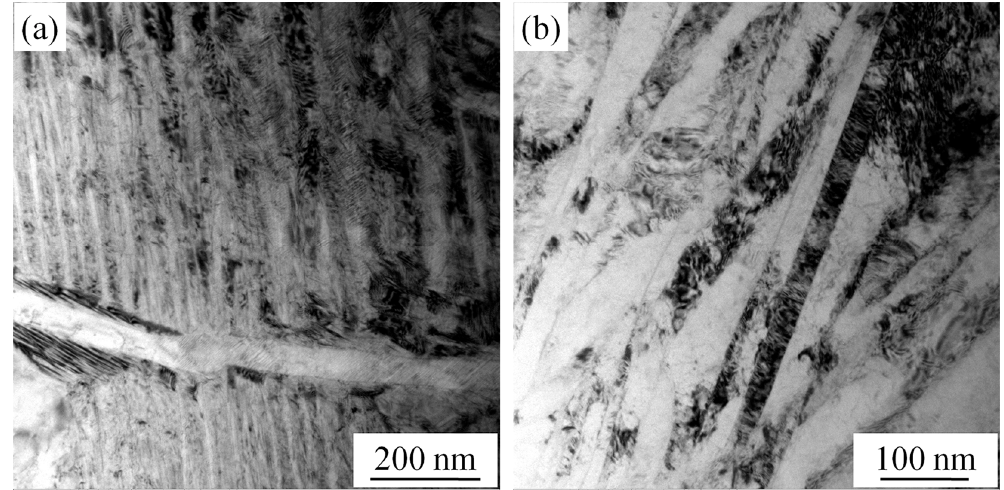
Figure 1. Transmission electron microscope (TEM) micrographs of as-rolled NiTiCu shape memory alloy (SMA): ( a ) Bright field image indicating martensite twins; ( b ) Bright field image indicating martensite laths.